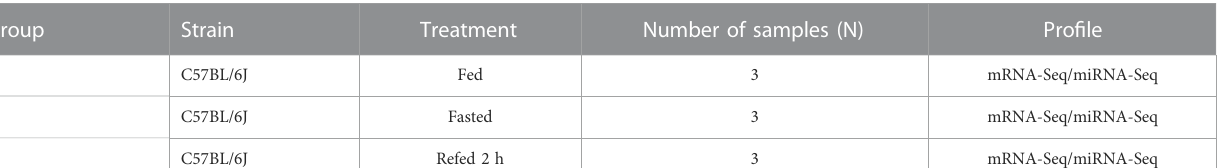
TABLE 1 Groups of mice used in this study.